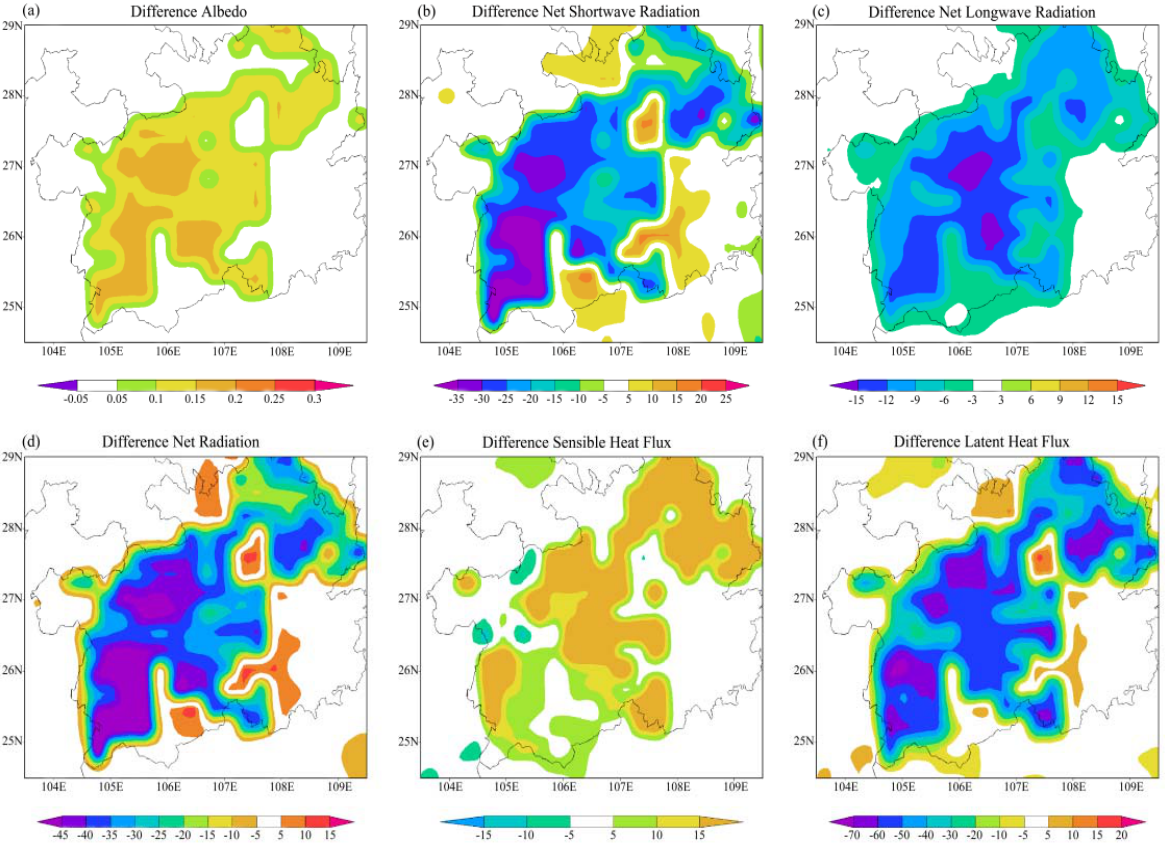
Figure 3. Ensemble mean differences in JJA ( a ) surface albedo; ( b ) net shortwave radiation; ( c ) net longwave radiation; ( d ) net radiation; ( e ) sensible heat flux; and ( f ) latent heat flux (W/m 2 ) between Case D and Case